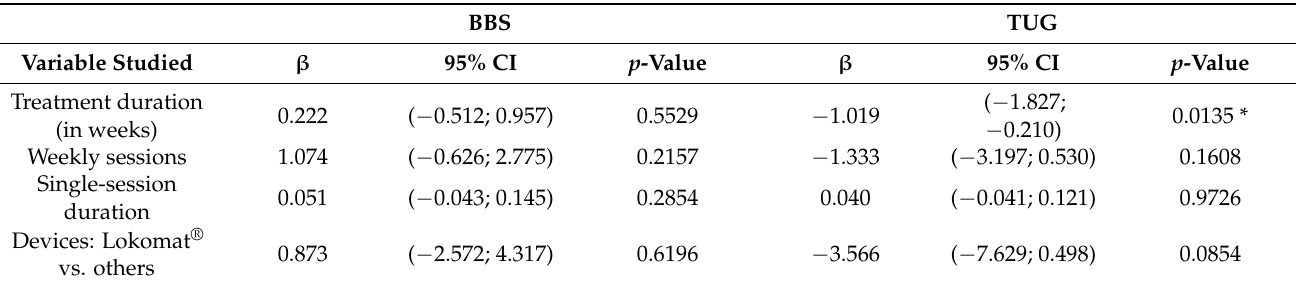
Table 1. Meta-regression performed on BBS and TUG. Each analysis is described with its β values and its respective 95% CI. * p -value <